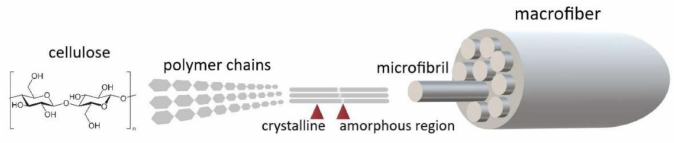
Figure 1. Structural organization of lignocellulosic plant fibers (original